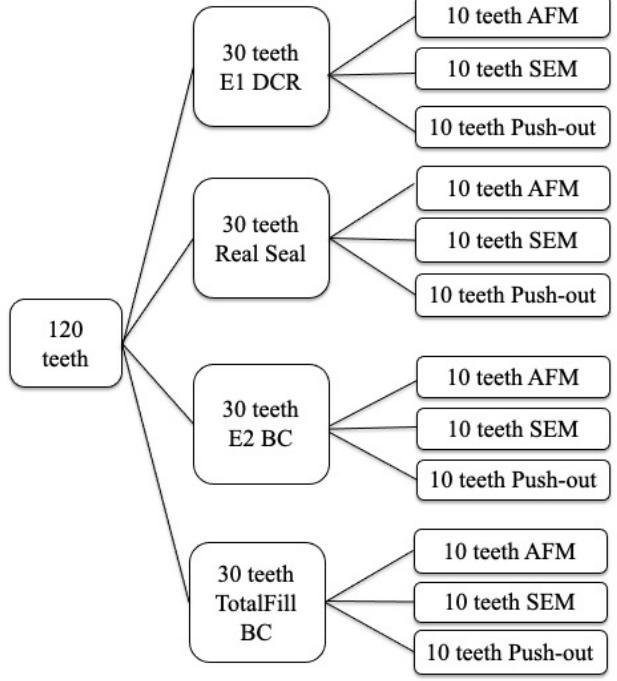
Figure 1. Sample distribution for SEM, AFM and Push-out study.